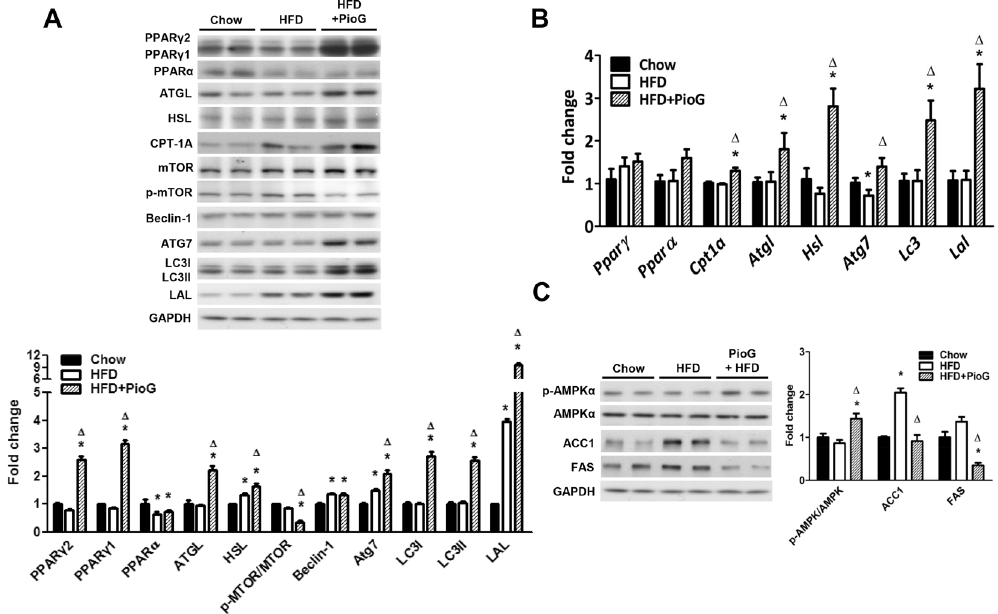
Figure 2. Pioglitazone enhanced cytosolic lipolysis, β -oxidation and autophagy but decreased lipogenesis. Mice were fed with chow diet, high fat diet, or high fat diet co-administered with pioglitazone (100 mg/kg/d) for 8 weeks. ( A ) Protein expressions related to cytosolic lipolysis (ATGL, HSL), β -oxidation (CPT-1A) and autophagy (mTOR, p-mTOR, Beclin-1, ATG7, LC3-I, LC3-II, and LAL) and the quantitative results. ( B ) Messenger RNA expressions of the above genes. ( C ) Protein expressions of the lipogenesis genes (FAS, ACC1) and the quantitative results. GAPDH served as a loading control. P < 0.05 indicated as significant, * vs chow diet, Δ vs high fat